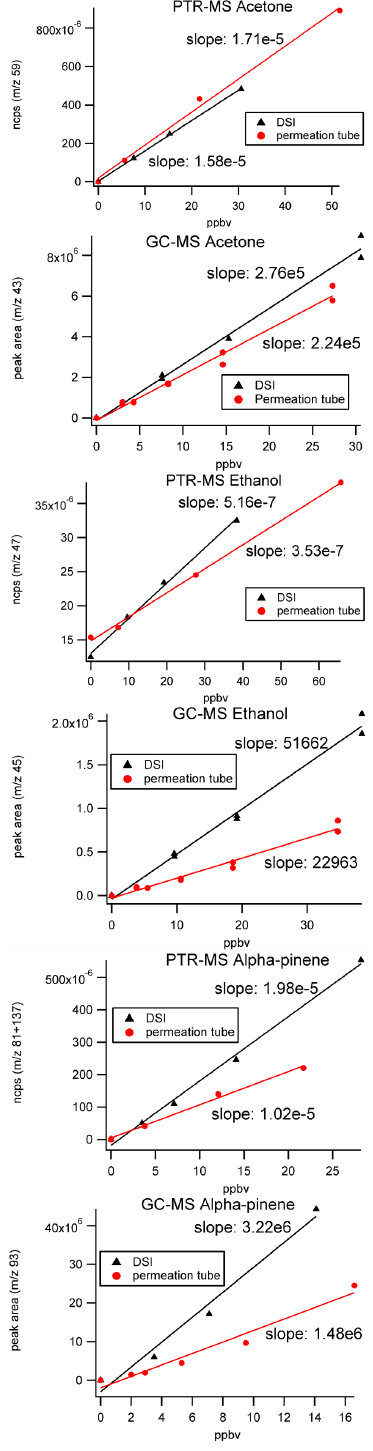
Fig. 4. Quantitative comparison of PTR-MS and GC-MS calibra- tion slopes using DSI and permeation tube methods for ethanol, acetone, and α